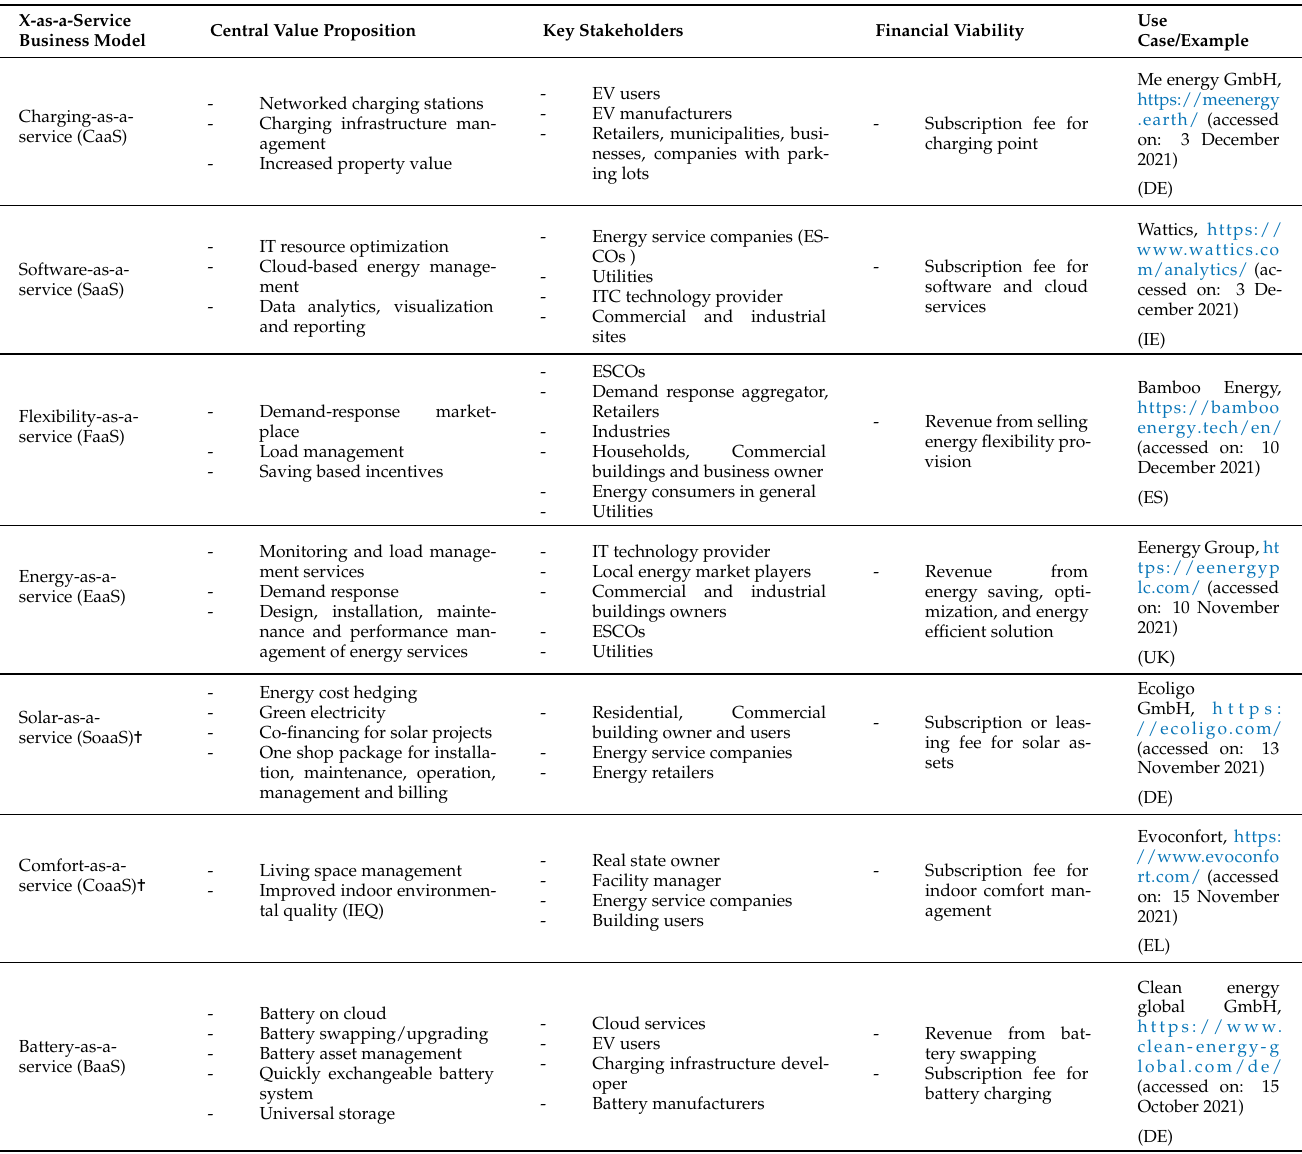
Table 1. XaaS services in energy sector ( (cid:61) To avoid confusion with other service model acronyms, these acronyms are modified in this